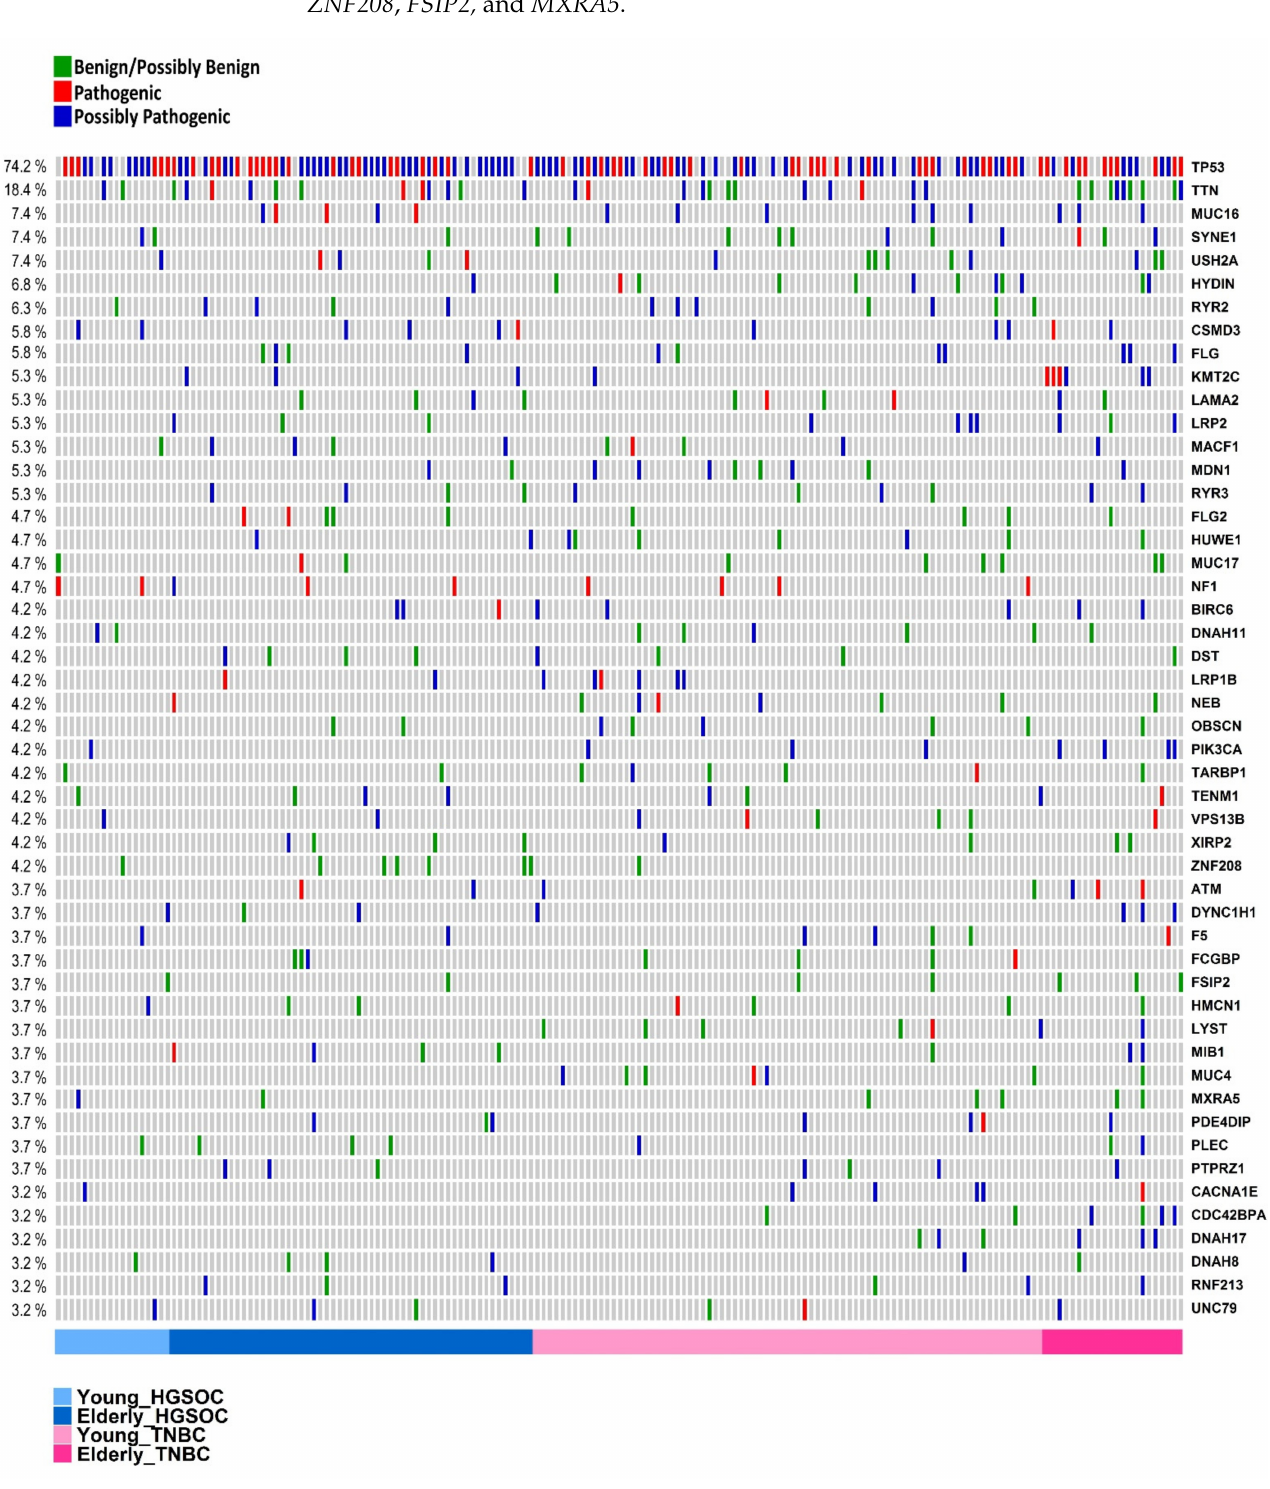
Figure 4. Frequently affected genes considering all samples of HGSOC and TNBC (young -Y and elderly -Y) classified according to their pathogenicity. Combined top 50 most frequently affected genes classified as potentially pathogenic (red), possibly pathogenic (blue) as described in methods, and benign (green). Each column represents a patient, and each line represents a gene (177 samples